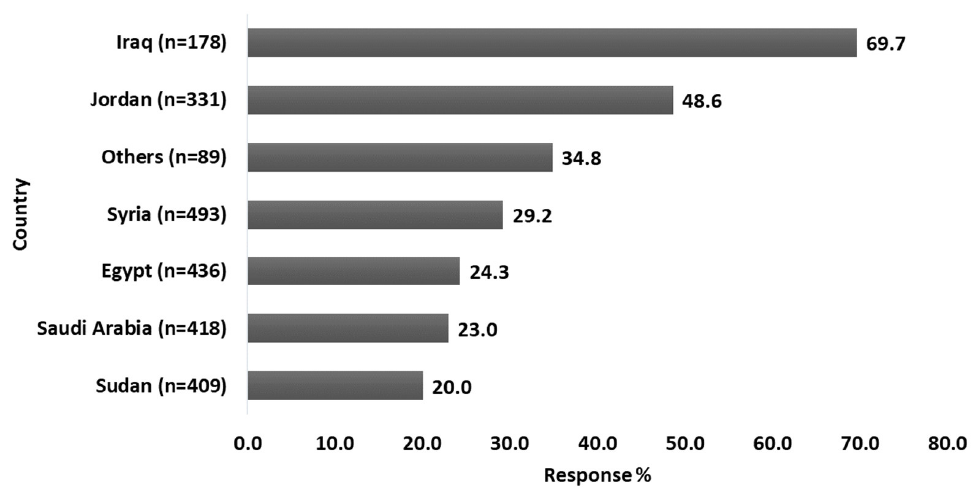
Figure 1. Participants’ response rate upon asking them if they ever (or any of their relatives/friends) use corticosteroids for any reason. Among the total sample size, only 744 (31.6%) participants had an experience with corticosteroid usage. Table 3. Participants’ reported experience with corticosteroid usage in different countries (total n = 744). Residential Country n (%)